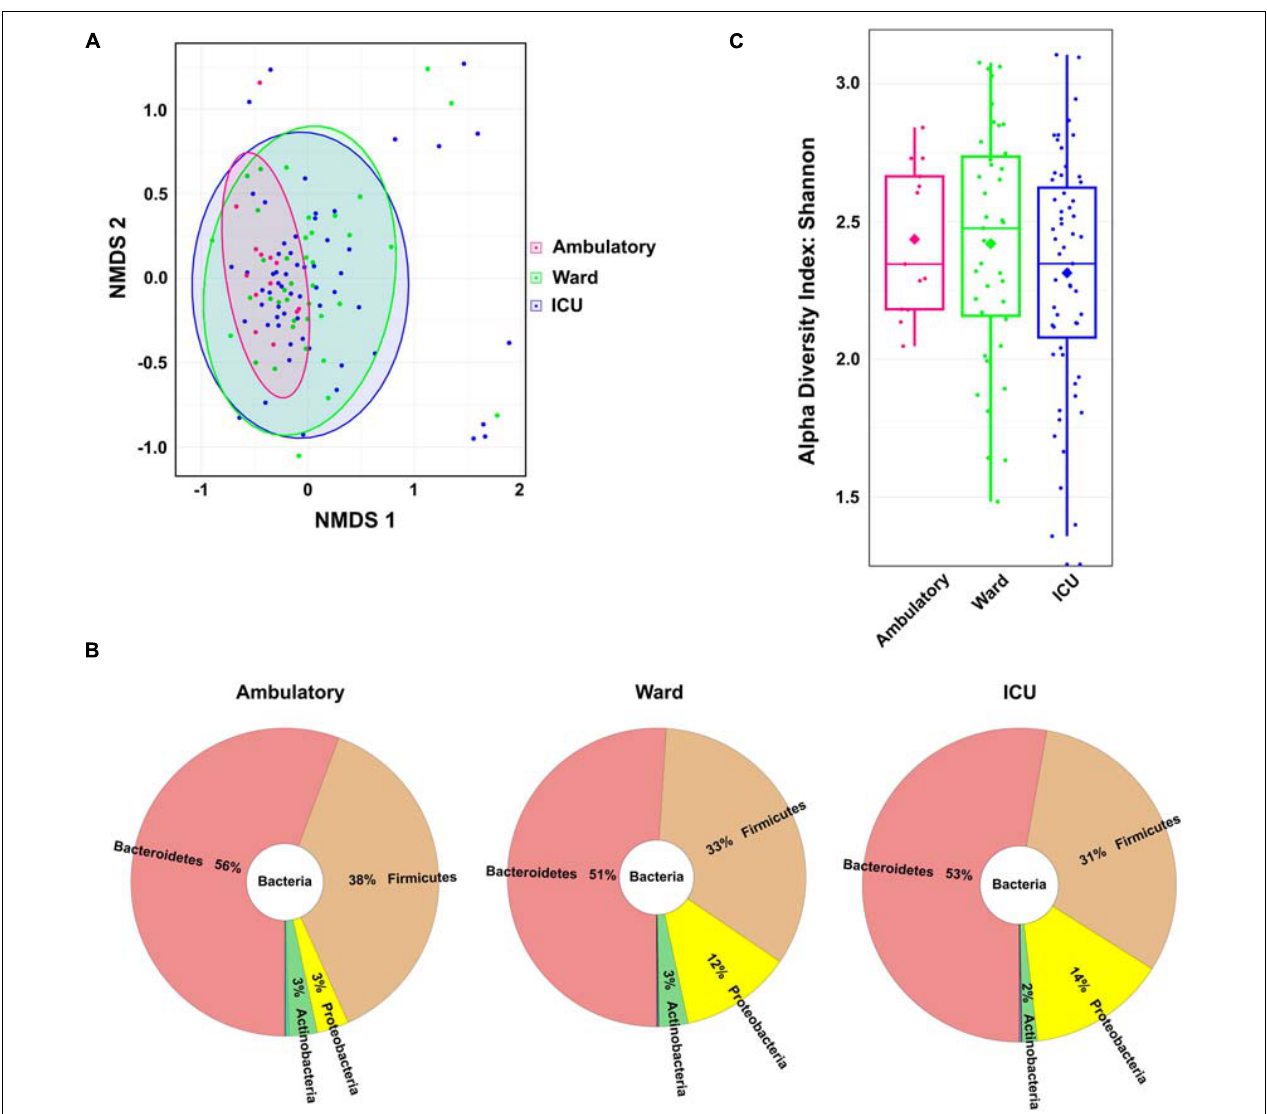
FIGURE 2 | Fecal microbiota composition of coronavirus disease 2019 (COVID-19) patients according to patient location of recovery: ambulatory, hospitalized in ward, or hospitalized in ICU. (A) Fecal microbiota community alterations according to patient location in the NMDS2 (non-metric multidimensional scaling) plot based on the Bray–Curtis dissimilarity. (B) Main bacterial phyla in the fecal samples of COVID-19 patients according to patient location. (C) Box plot of the alpha diversity (measured by the Shannon diversity index) of the COVID-19 patients according to patient